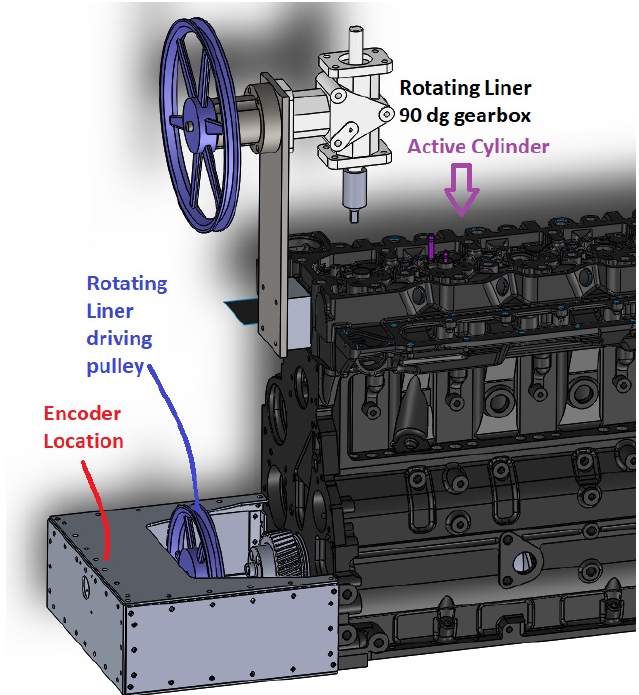
Figure 10. Overall RLE prototype, showing encoder location and revised gearbox. For more details on the prototype geometry, see the Appendix A.